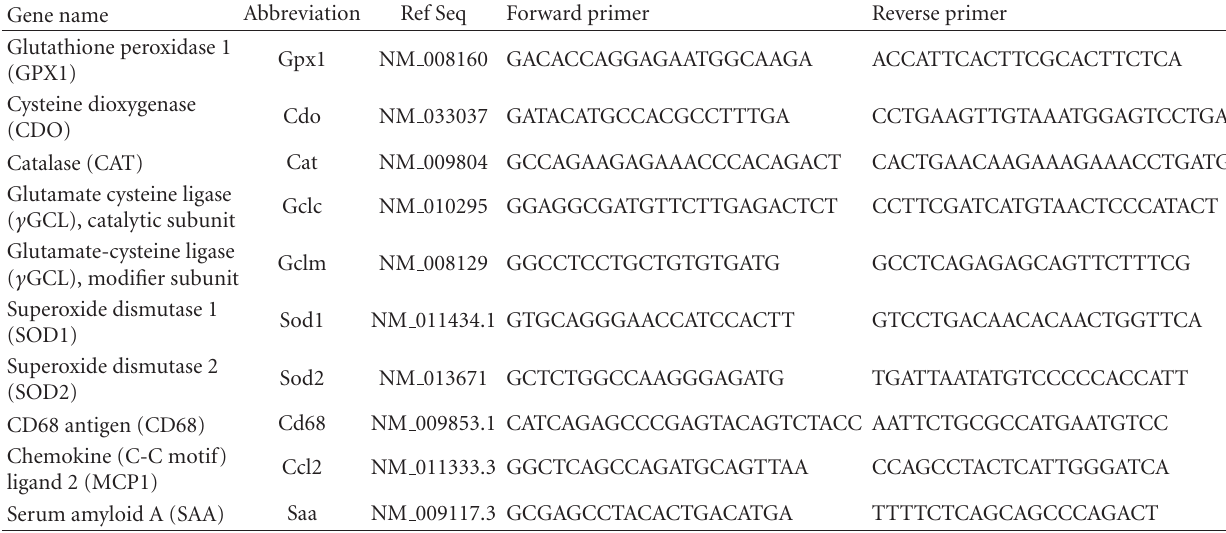
Table 1: Primer sequences used in quantitative RT-PCR